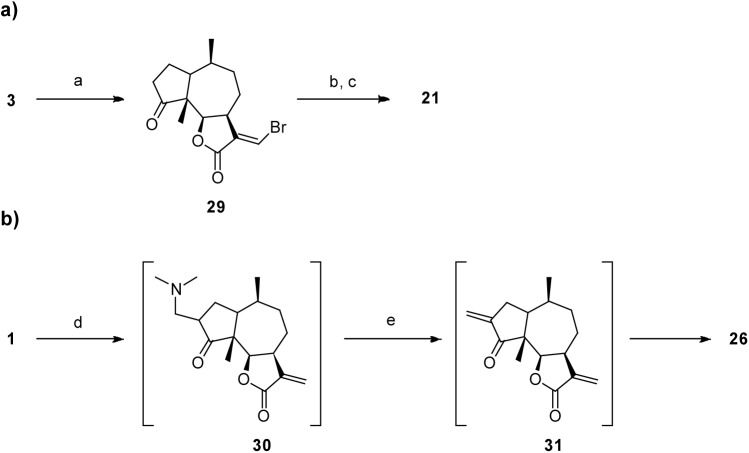
Reaction conditions.
a) Suzuki coupling conditions: a. Et3N/DCM; b. PrI, Buli, B-methoxy-9-BBN/ Et2O, THF; c. K3PO4(aq), 29, PdCl2(dppf)⋅CH2Cl2/DMF. b) Mannich condensation: d. H2C = N+(CH3)2, CF3CO2-/DCM; e. MeI/MeOH.